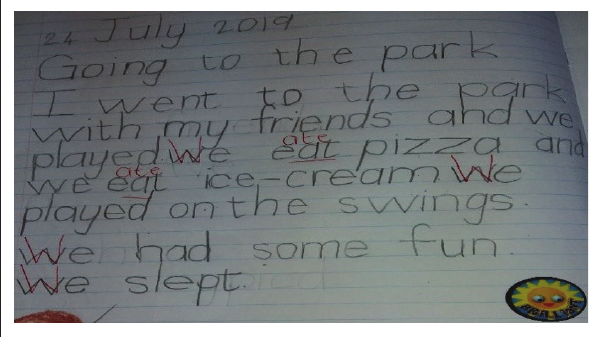
FIGURE 6: Incorrect tenses in creative writing.